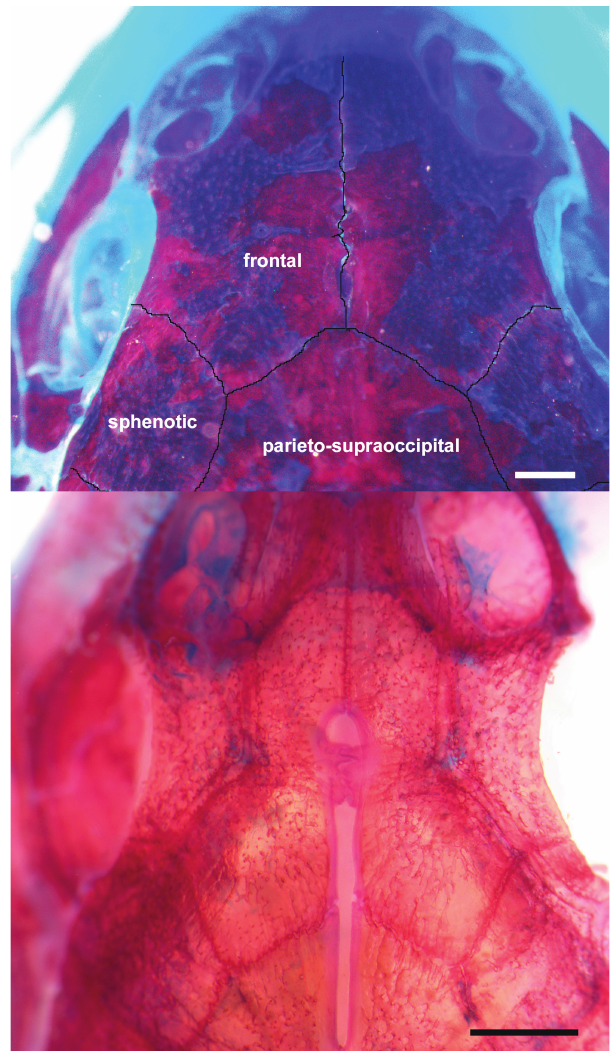
Fig. 3. Detail of dorsal view of cranium of Scleromystax reisi , paratype, female, MNRJ 43857 (top), and S. salmacis , male, MCP 28729 (bottom; flipped horizontally, left infraorbitals and suspensorium removed). Solid lines detaching limits of bone sutures. Scale bar: 1.0 mm.